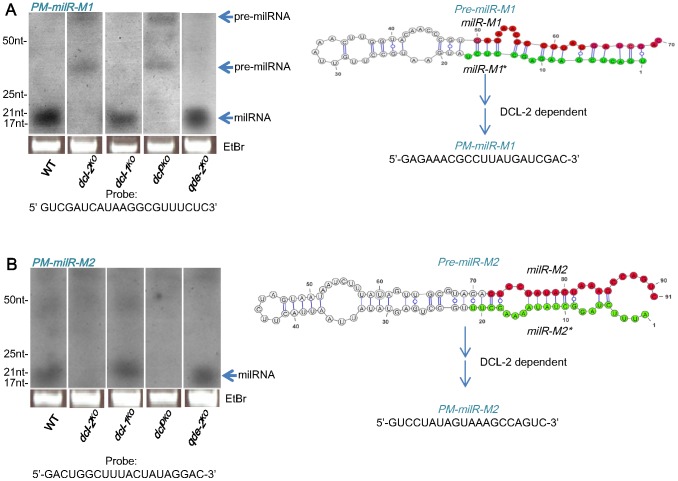
milRNA biogenesis mechanism for PM-milR-M1 and PM-milR-M2 in P. marneffei.Northern blot analyses of small RNA samples in wild-type (WT), dcl-1KO, dcl-2KO, dclDKO and qde-2KO strains of P. marneffei showing that the production of milRNA of (A) PM-milR-M1 and (B) PM-milR-M2 requires DCL-2 but not DCL-1 or QDE-2. The ethidium bromide-stained denaturing gel in the bottom panel showed equal loading of RNA. Predicted structures of pre-milRNA of PM-milR-M1 and PM-milR-M2, with their milRNA and paired milRNA* sequences as labeled in red and green respectively, are shown next to the northern blot analyses. The probe sequences used for northern blot analyses are marked.